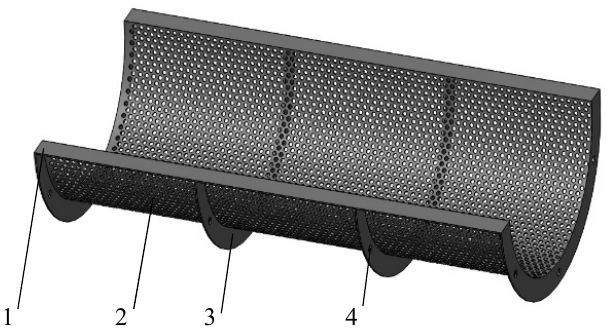
Figure 15. The 3D structure diagram of separation concave plate. 1. Connecting plate with the upper cap; 2. Perforated screen; 3. Arcuate side-plate; 4. Bolt hole.